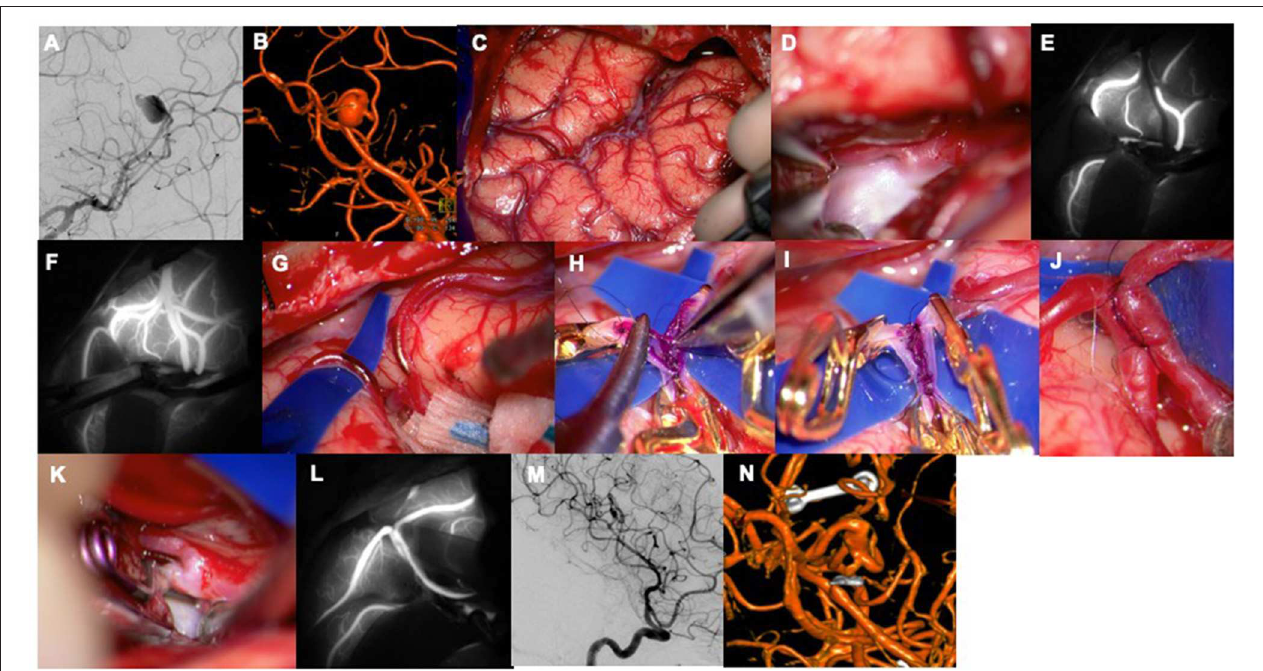
FIGURE 2 | A 47-year-old woman presented with a sudden headache suspicious for sentinel hemorrhage. (A) An aneurysm was found at the distal M2 segment with dolichoectatic morphology and two efferent branches (left ICA, AP view). (B) Left ICA, 3D reconstruction. (C) Sylvian fissure split to access the insular recess. (D) Aneurysm with parent artery. (E) Flash fluorescence technique was used to identify the efferent vessel to be used as a bypass recipient with proximal temporary clip occlusion. (F) Temporary clip removal led to flash ICG filling of this vascular territory and showed the angular artery as the outflow vessel. (G) In situ bypass of angular artery with posterior temporal artery was performed. (H) The intraluminal suture line was sewn with a single anchoring stitch to better visualize the walls. (I,J) The extraluminal suture line was sewn loosely, tightened, and tied. (K) Proximal aneurysm occlusion. (L) M3 MCA-M3 MCA in situ bypass perfused the donor angular artery as seen with ICG-VA. (M) Left ICA, lateral view. (N) Left ICA, 3D reconstruction. Used with permission from Lawton